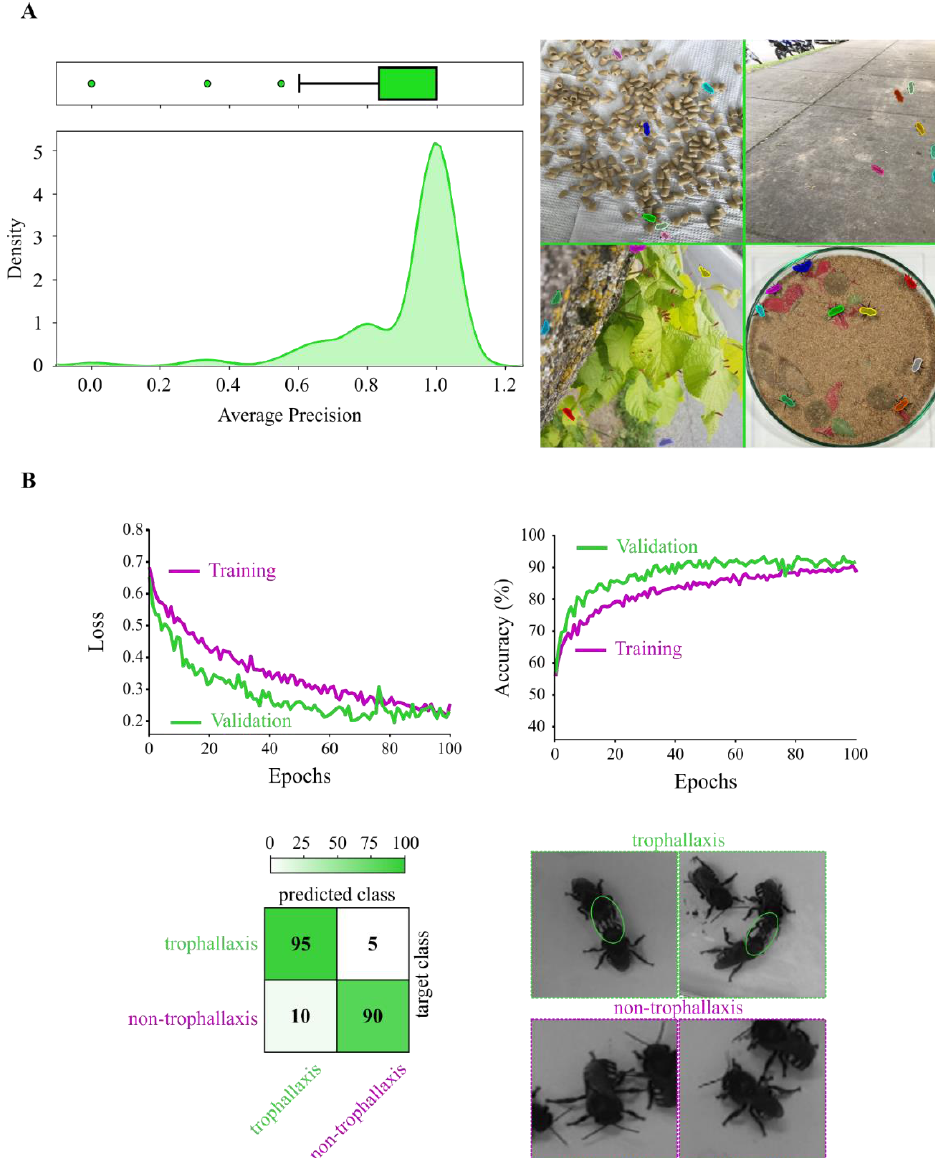
Figure 7. Performance of the AI models used in Ethoflow. ( A ) Animals’ detection in heterogeneous environments based on instance segmentation (IS). The high average precision (left panel; n = 100) implies that the model precisely detects real animals in the scenes with no false positives, as demonstrated by (right panel) the detected animals (marked Melipona quadrifasciata bees with masks in random colors) in different heterogeneous backgrounds. ( B ) The training process of the CNN model (top panel) and validation (percentage confusion matrix; bottom left panel) ( n = 127) for the monitoring of trophallaxis (green circles) in bees (bottom right panel).